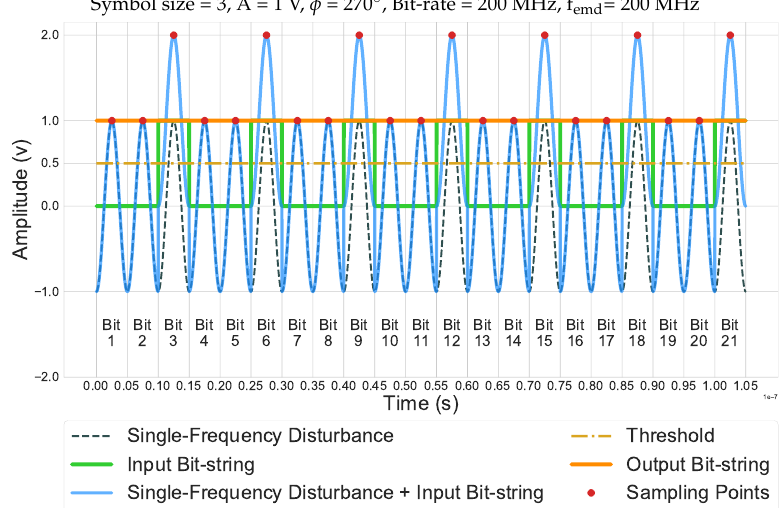
Figure A1. Behavior of one code word under a single-frequency